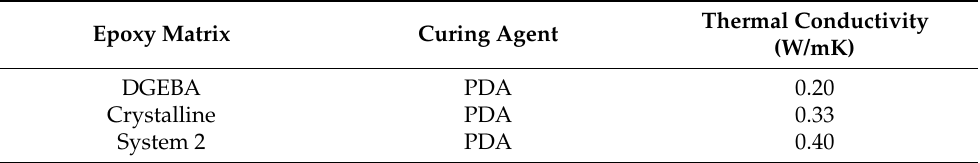
Table 1. Thermal conductivities of DGEBA, crystalline epoxy resin, and System 2 cured with p -phenylenediamine (PDA). Reproduced from Ref. [31] with permission from The Royal Society of